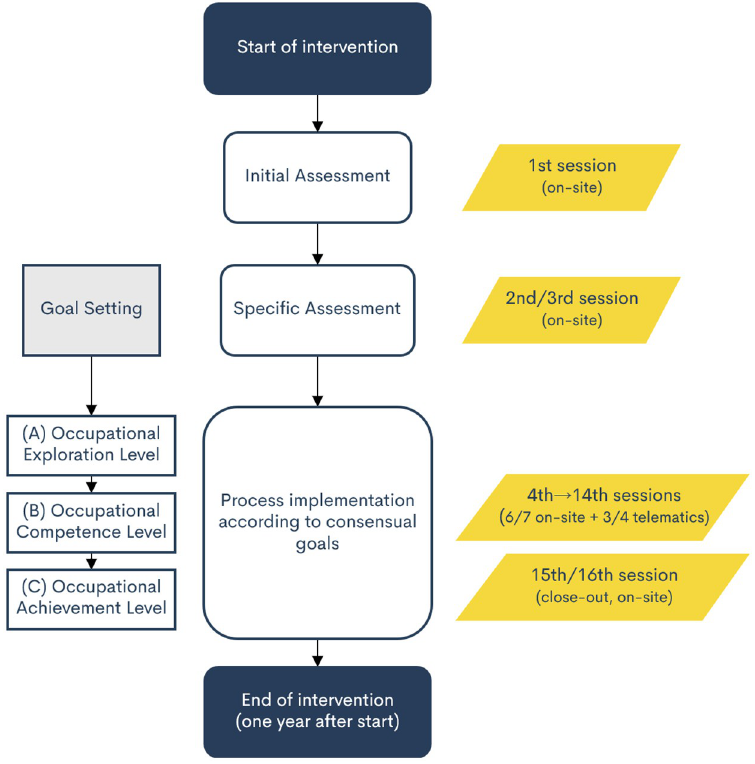
specific assessment. Subsequently, between the 4th and the 16th session (on-site and telematics), the intervention will be implemented according to the goals and through the three-level process (Exploration, Competence and Achievement) based on the Model of Human